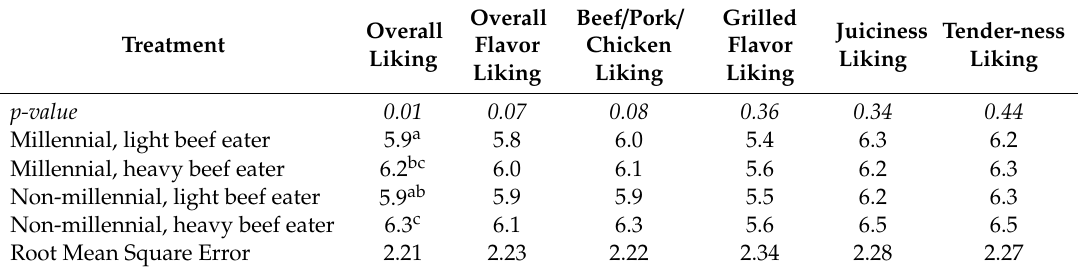
Table 2. Least square means for consumer sensory attributes across consumer groups adapted from Laird (2015)